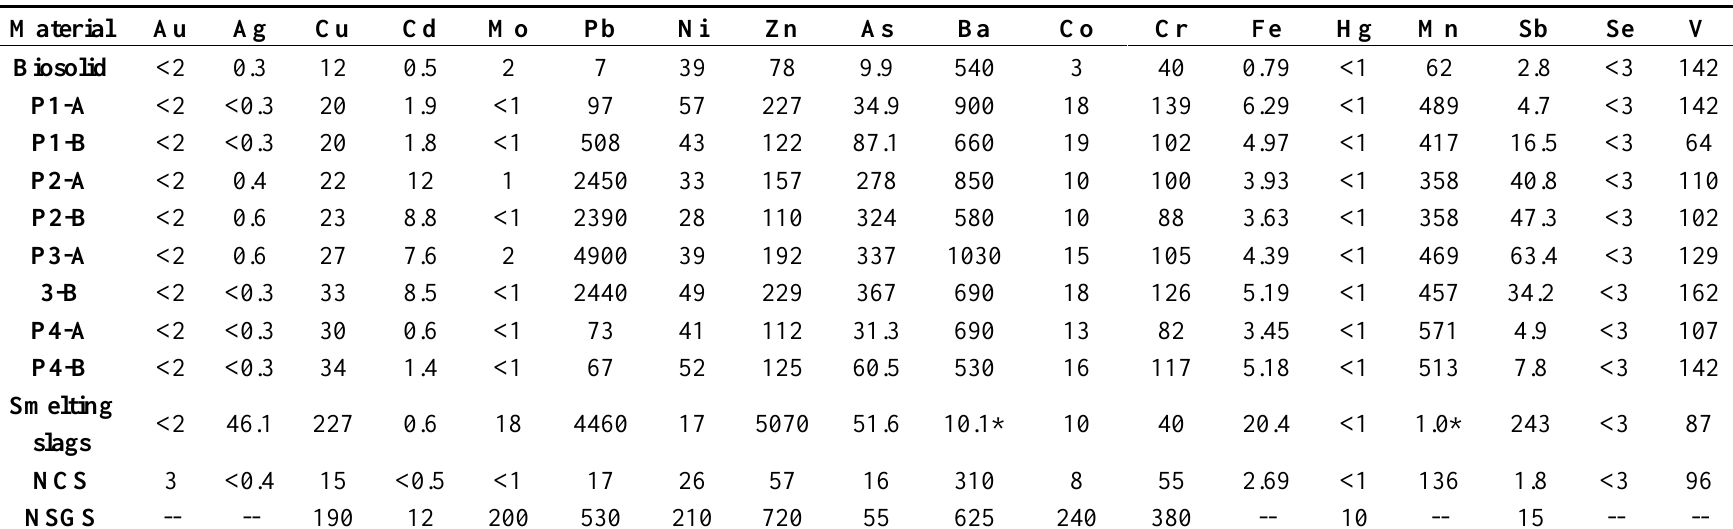
Table 2. Geochemical composition of biosolid, and contaminated materials (contaminated soils P1 to P4 and smelting slags) used in the leaching experiments. Values in mg/kg, except Au (ppb) and Fe